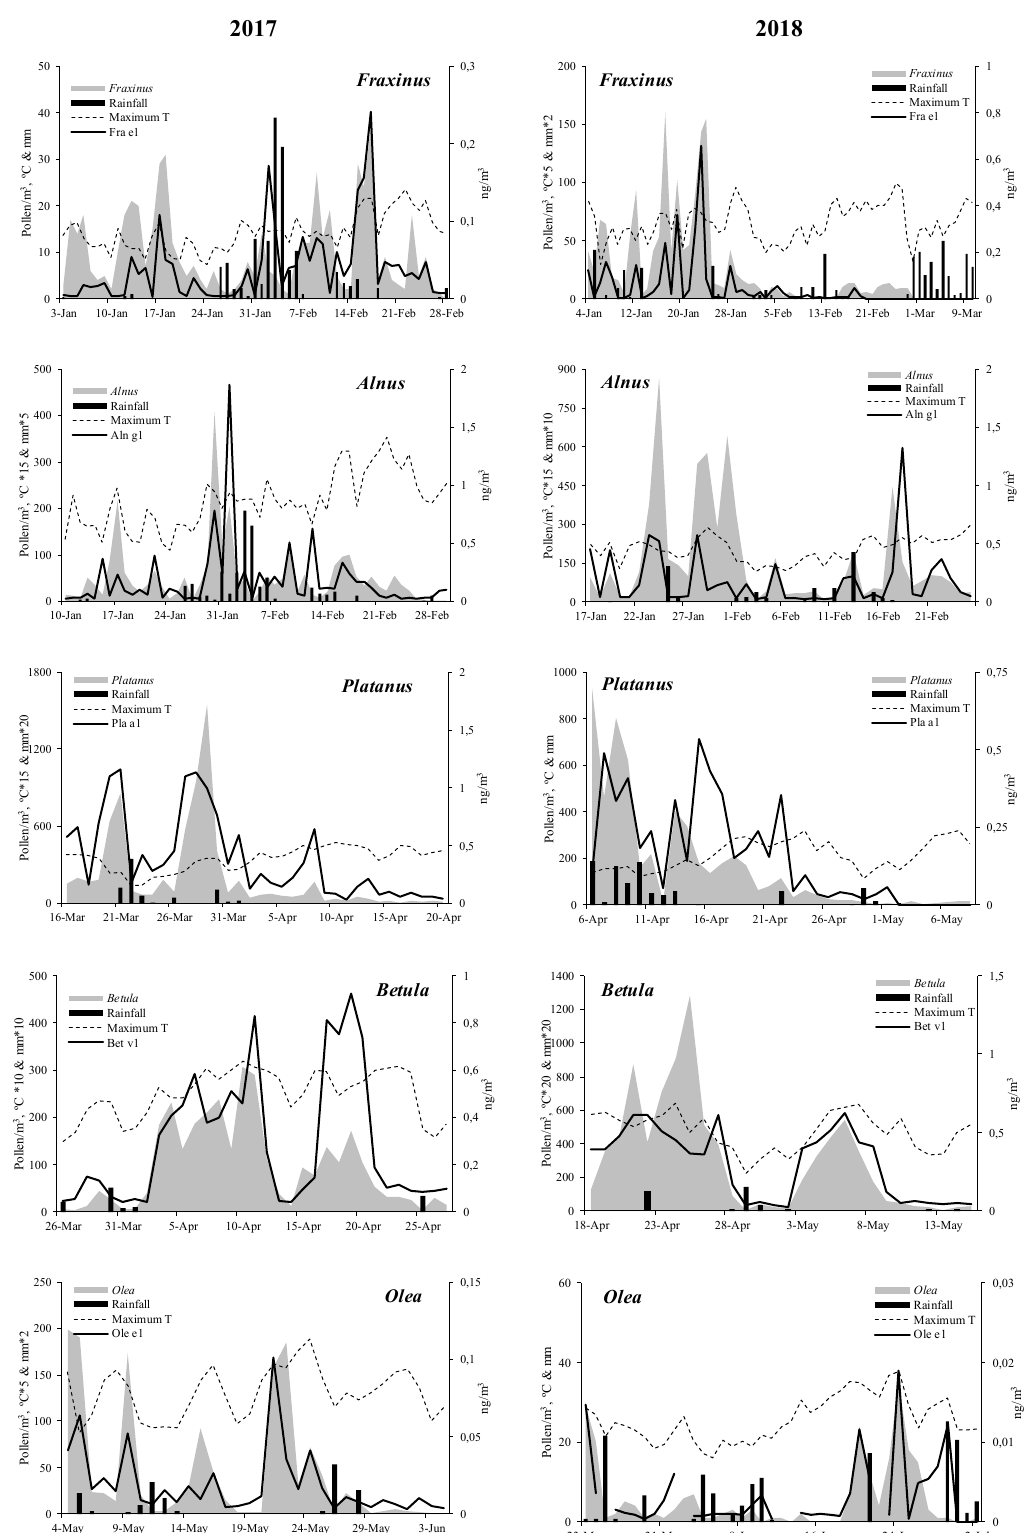
Figure 2. Pollen grain concentrations (grey area), allergen concentrations (black line), maximum temperature (points line) and rainfall (bar) for Alnus , Betula , Fraxinus , Olea and Platanus during the MPS.